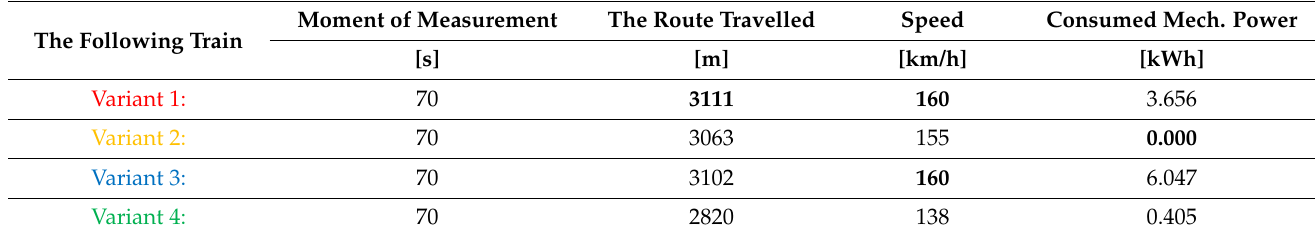
Table 4. Results for variants PN according to context